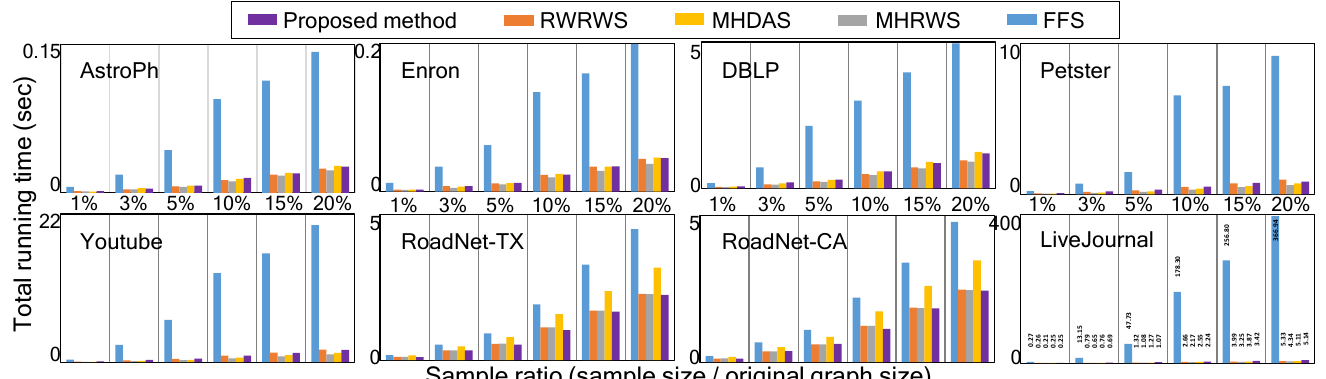
Figure 9. Comparison of total run time of sampling methods (colored). To handle extremely large network databases with limited access effectively, we can easily extend the proposed method by generating multiple cbs in parallel, as outlined in = 0. Then, differing from Algorithm 2. First, cbs 0 is processed as in Algorithm 1 with m cbs 0 Algorithm 1, as many as the hub nodes | cbs | − 1 are selected in the descending order of d ( i ) from the generated cbs 0 . Finally, other cbs ( cbs z , z > 0) begin simultaneously from each hub as a seed node to realize parallelized sampling. From a scalability perspective, the proposed method can be also executed on existing distributed systems to analyze of huge